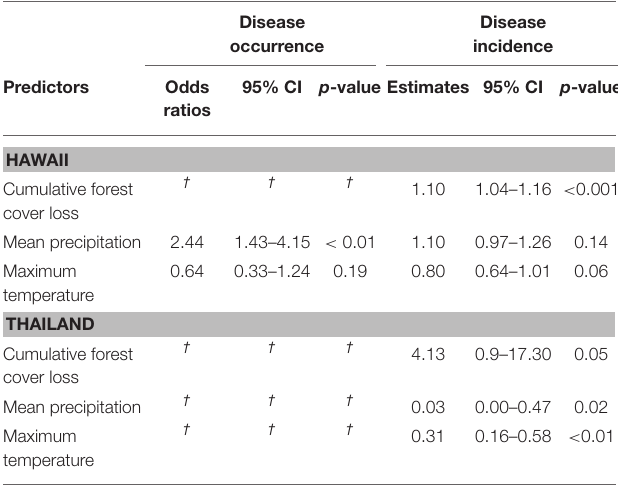
TABLE 2 | Best-fitting hurdle-based models explaining the effect of forest cover loss on rat lungworm disease occurrence and incidence in Hawaii and Thailand. Disease